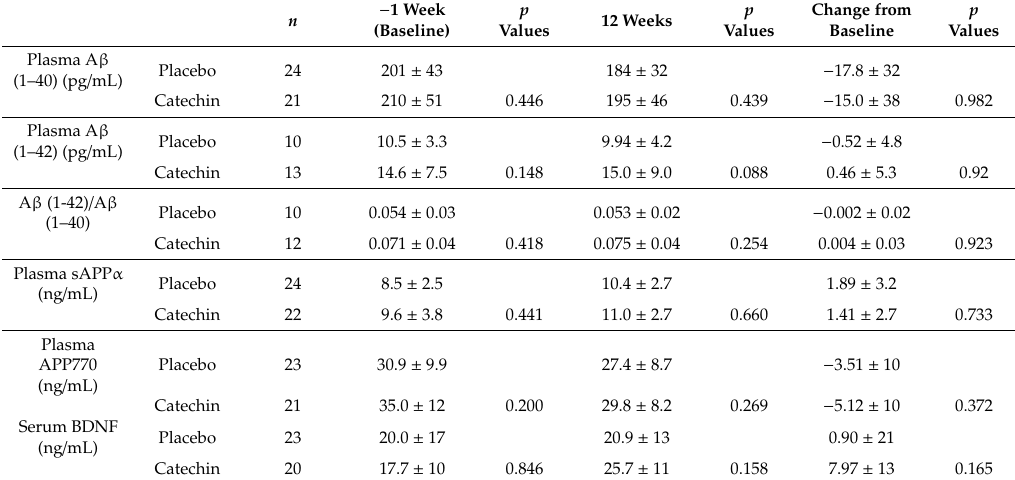
p Change from Values Baseline